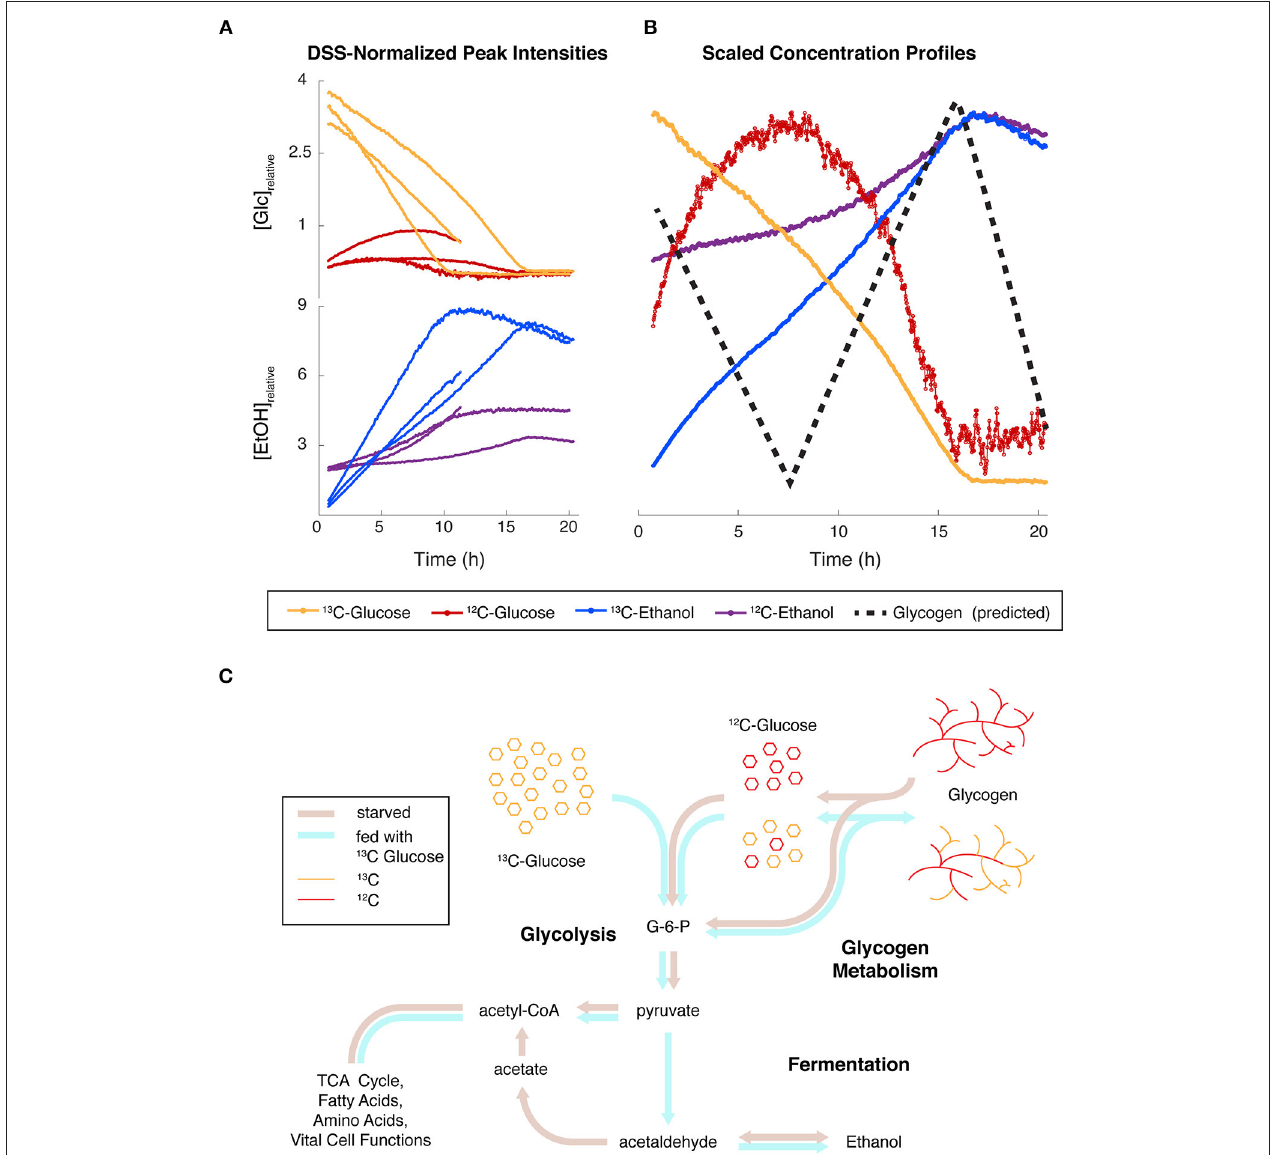
FIGURE 6 | Simultaneous monitoring of carbon isotopes reveals convergence of major glucose fluxes from different origins. (A) Relative concentrations for Glucose (Glc) and Ethanol (EtOH) containing 12 C and 13 C in N. crassa cultures fed with 13 C-labeled glucose ( t = 0h) after 2h of starvation. Protons covalently attached to 12 C and 13 C were differentiated in noesypr1d experiments by 13 C-induced splitting. Three independent replicates are shown. One replicate was only recorded for 11h. (B) Relative concentrations scaled by the maximum of each trajectory of one replicate highlight the relationships between trends. A hypothesized glycogen trajectory is plotted as a black dotted line. (C) Hypothesized fluxes through glycolysis, glycogen metabolism, and fermentation under starved (brown arrows) and fed (blue arrows)